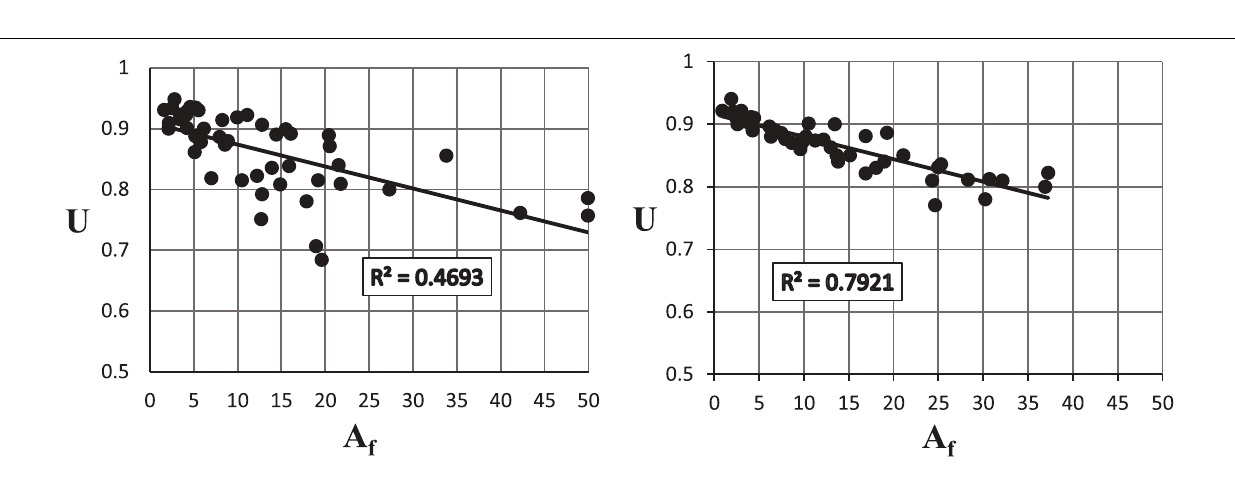
FIGURE 9 | U vs. A f based on FEA for W (left) and WT (right) sections (12 in. connection).